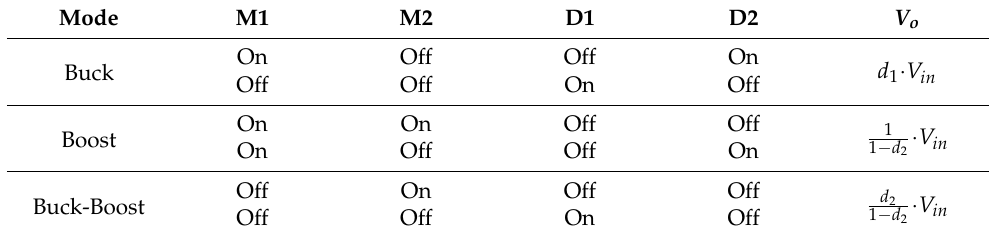
Table 1. Buck-boost switch operation modes.